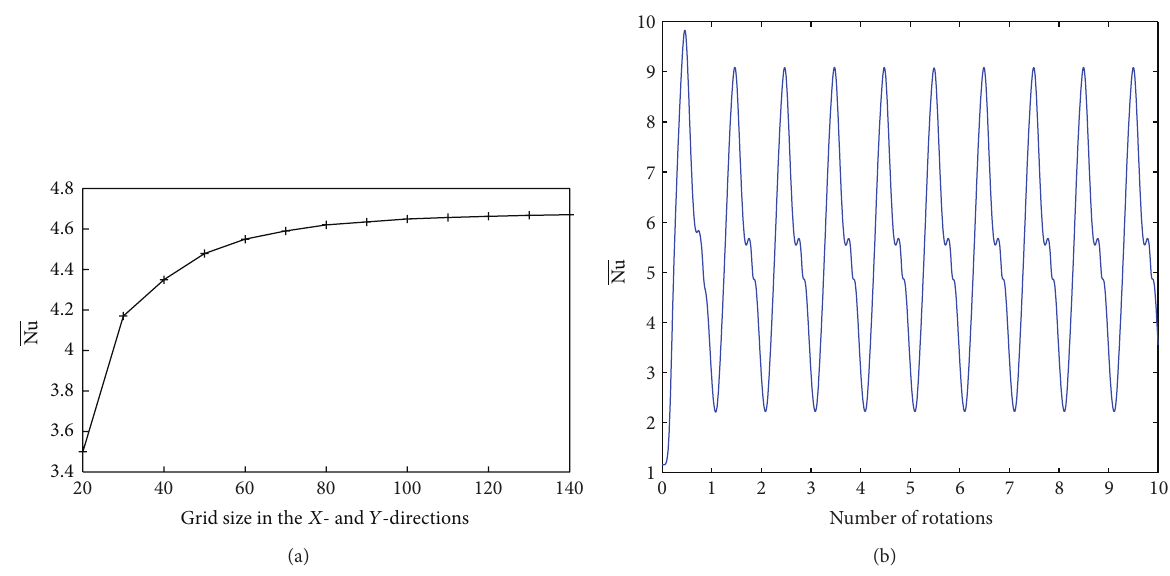
= 4.7×10 3 at 𝜑 = 𝜋/2 ; (b) typical computation bf